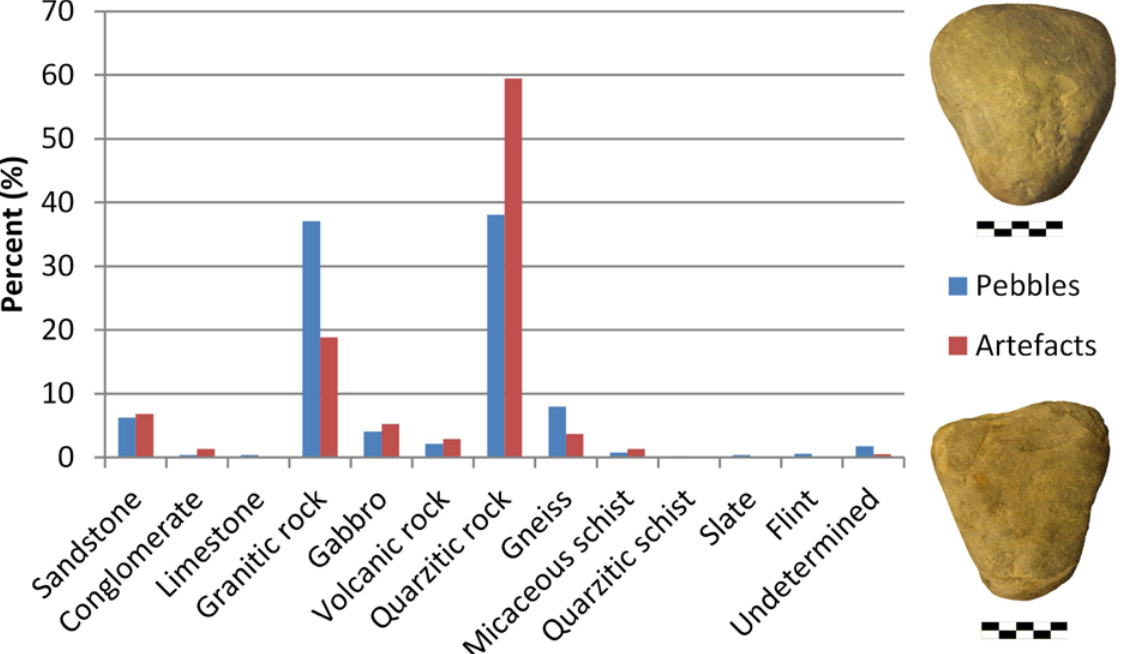
Figure 5. Percentual frequencies of different rock types determined for all artefacts and unmodified and unused pebbles excavated in the wet soil area of Bruszczewo. (The scale bars are 5 cm wide, in 1 cm